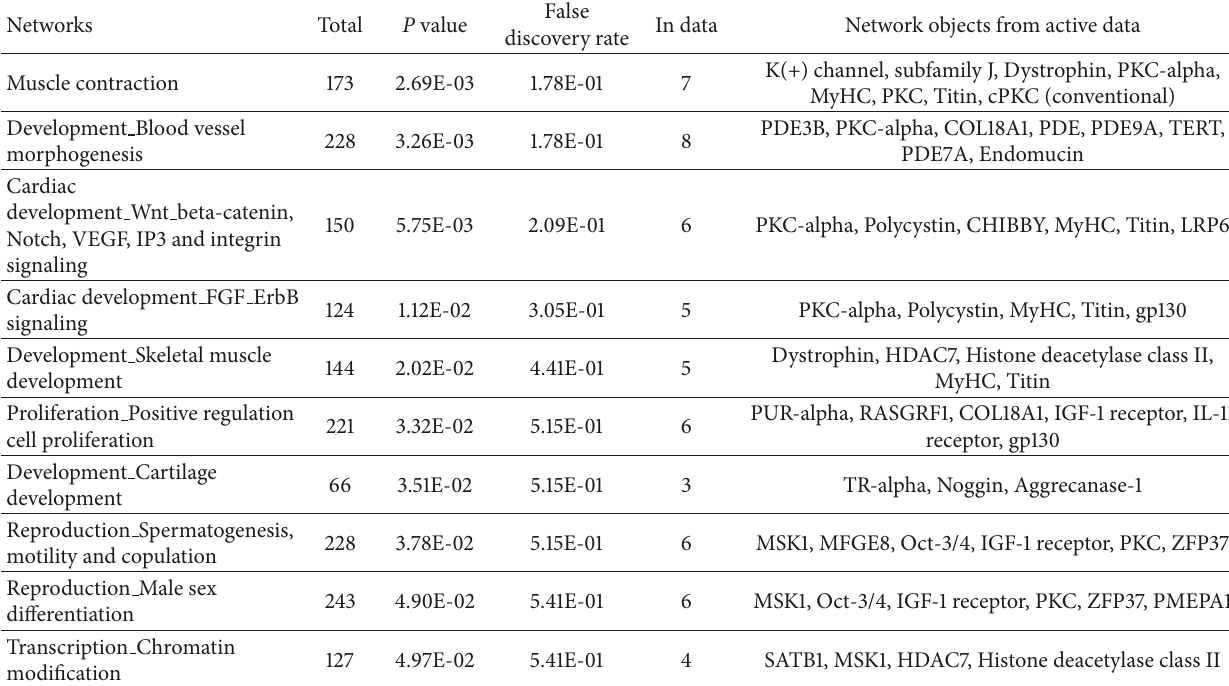
Table 4: Biological process networks for 586 genes whose expression in peripheral CD4+ cells was negatively correlated with serum IL-8